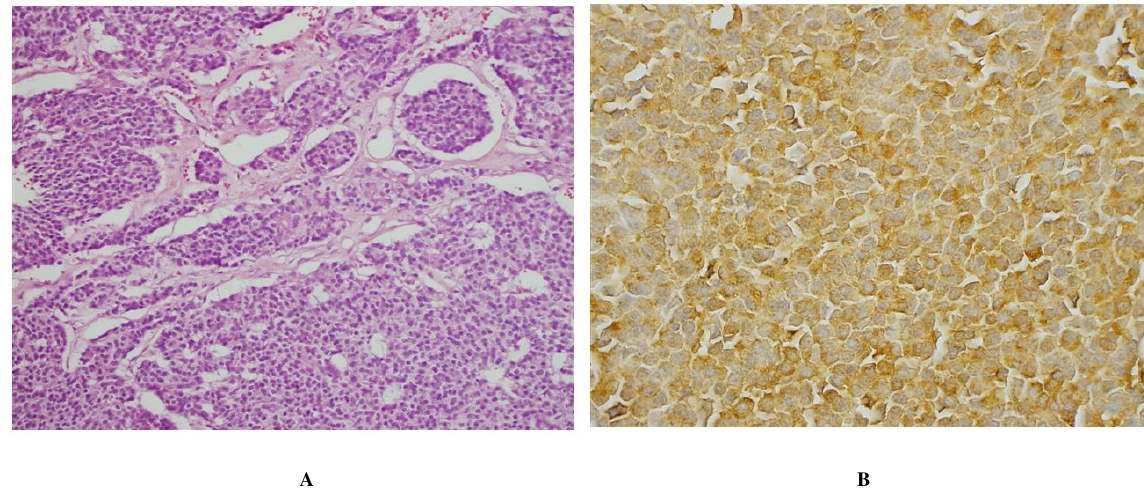
FIGURE 2. (A) Hematoxylin & Eosin stain, 25 × . (B) Tumor tissue stain positive for gastrin, 60 ×